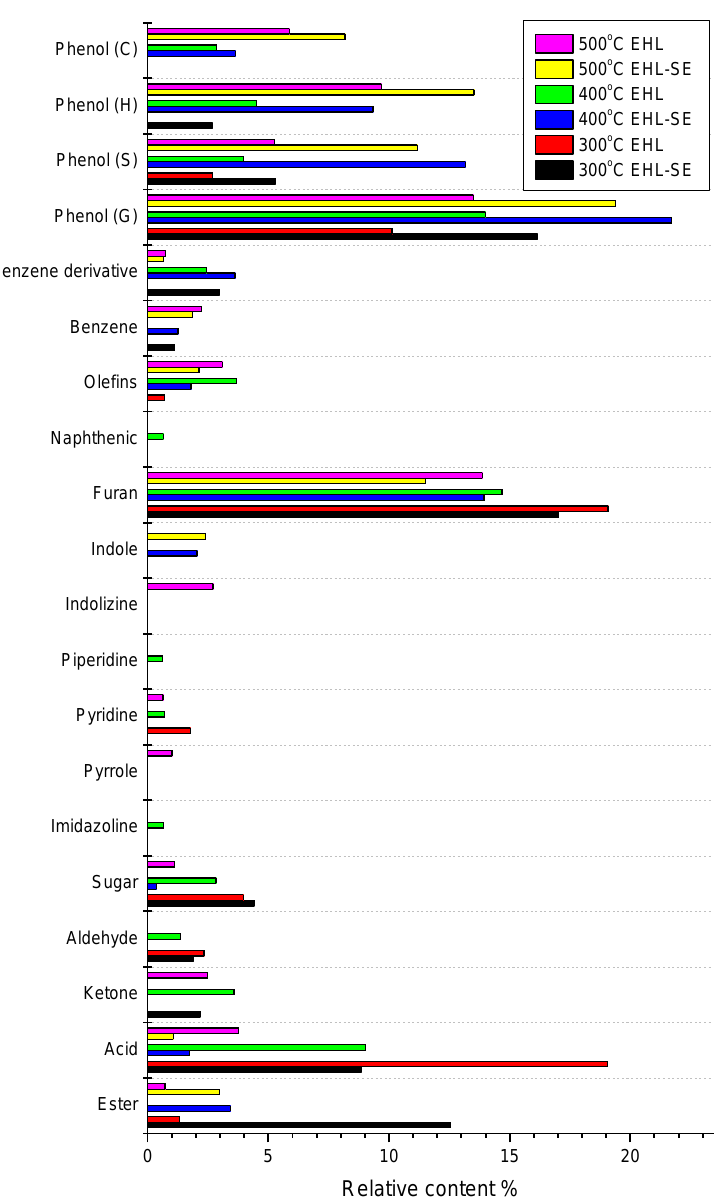
Figure 4. Total product distribution obtained by pyrolysis of EHL and EHL-SE with different temperatures.